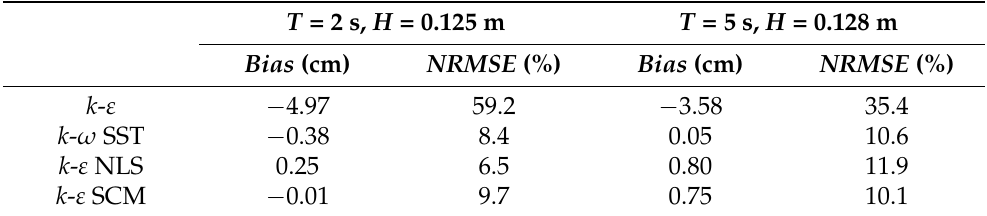
Figure 9. Maximum and minimum wave height envelopes and mean water level in the spilling case by using k- ε , k- ω SST, k- ε NLS and k- ε SCM turbulence models. Table 3. Bias and NRMSE of wave height for spilling and plunging cases and k- ε , k- ω SST, k- ε NLS and k- ε SCM turbulence models.